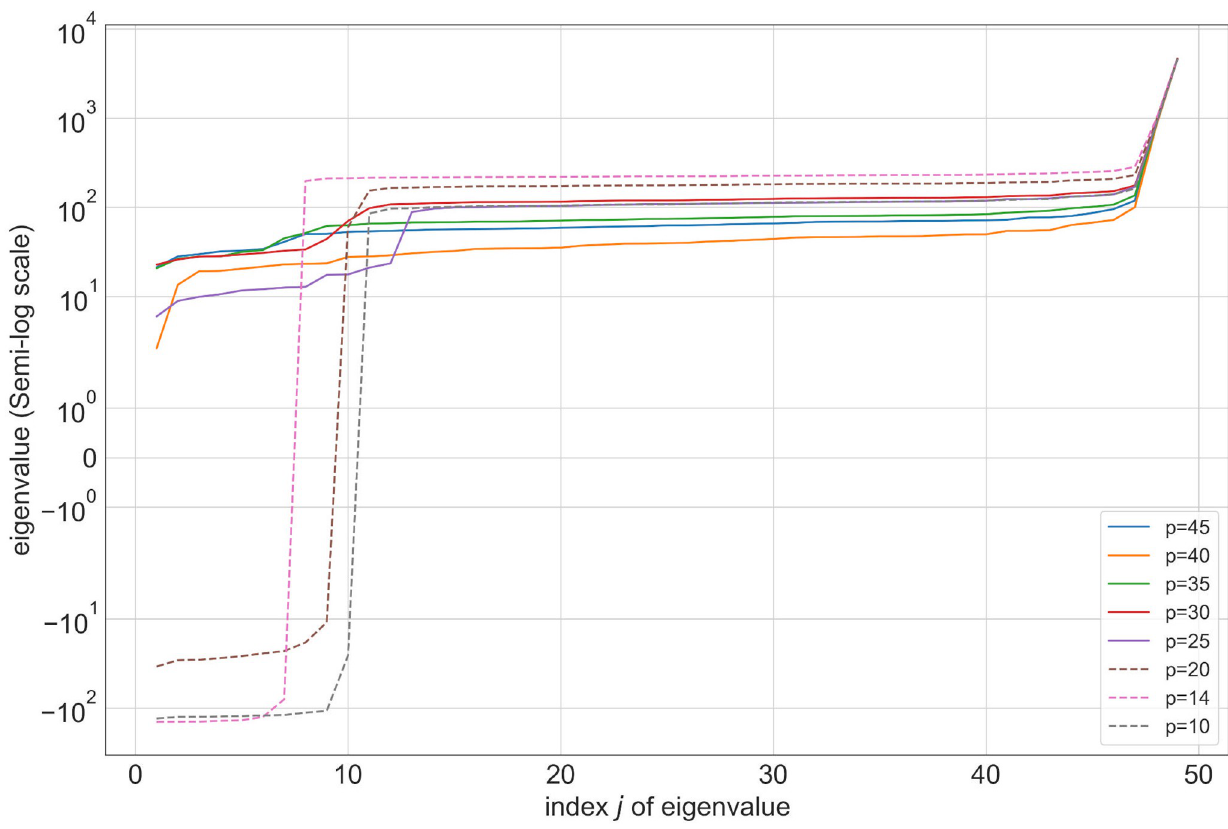
Fig 5. Eigenvalues of ^ Q for | F | = 49 and different p values. The objective function with p p = 20 are drawn with dotted lines to highlight the loss of positive definiteness and hence